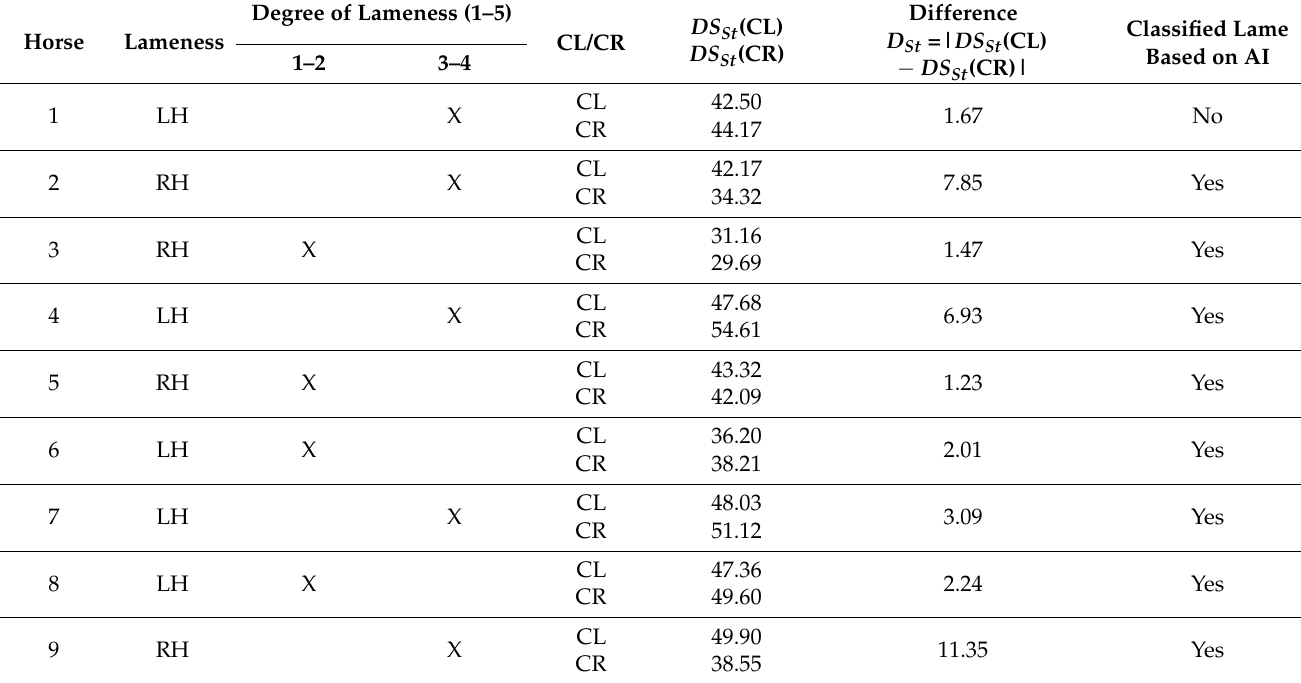
Table 1. Stifle reference point—Hindlimb-lame